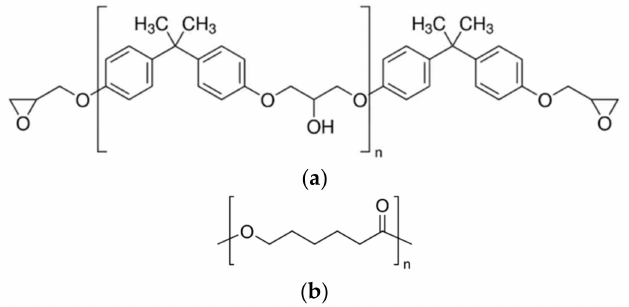
Figure 1. Chemical structures: ( a ) DGEBA, ( b )